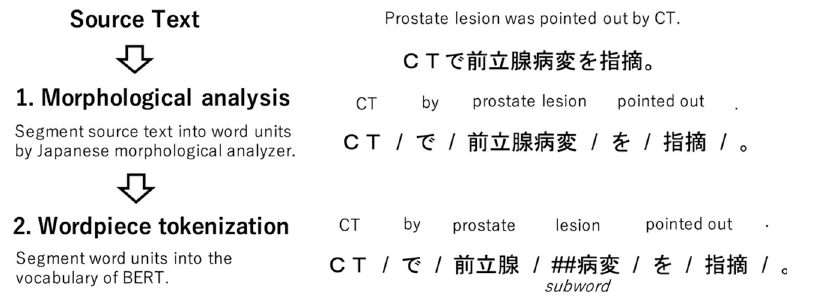
Fig 1. The schematic view of morphological analysis and wordpiece